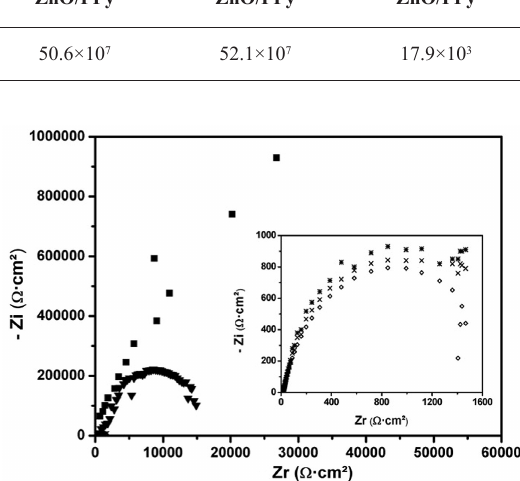
Table 1. Resistance obtained at zero immersion time. Substrate